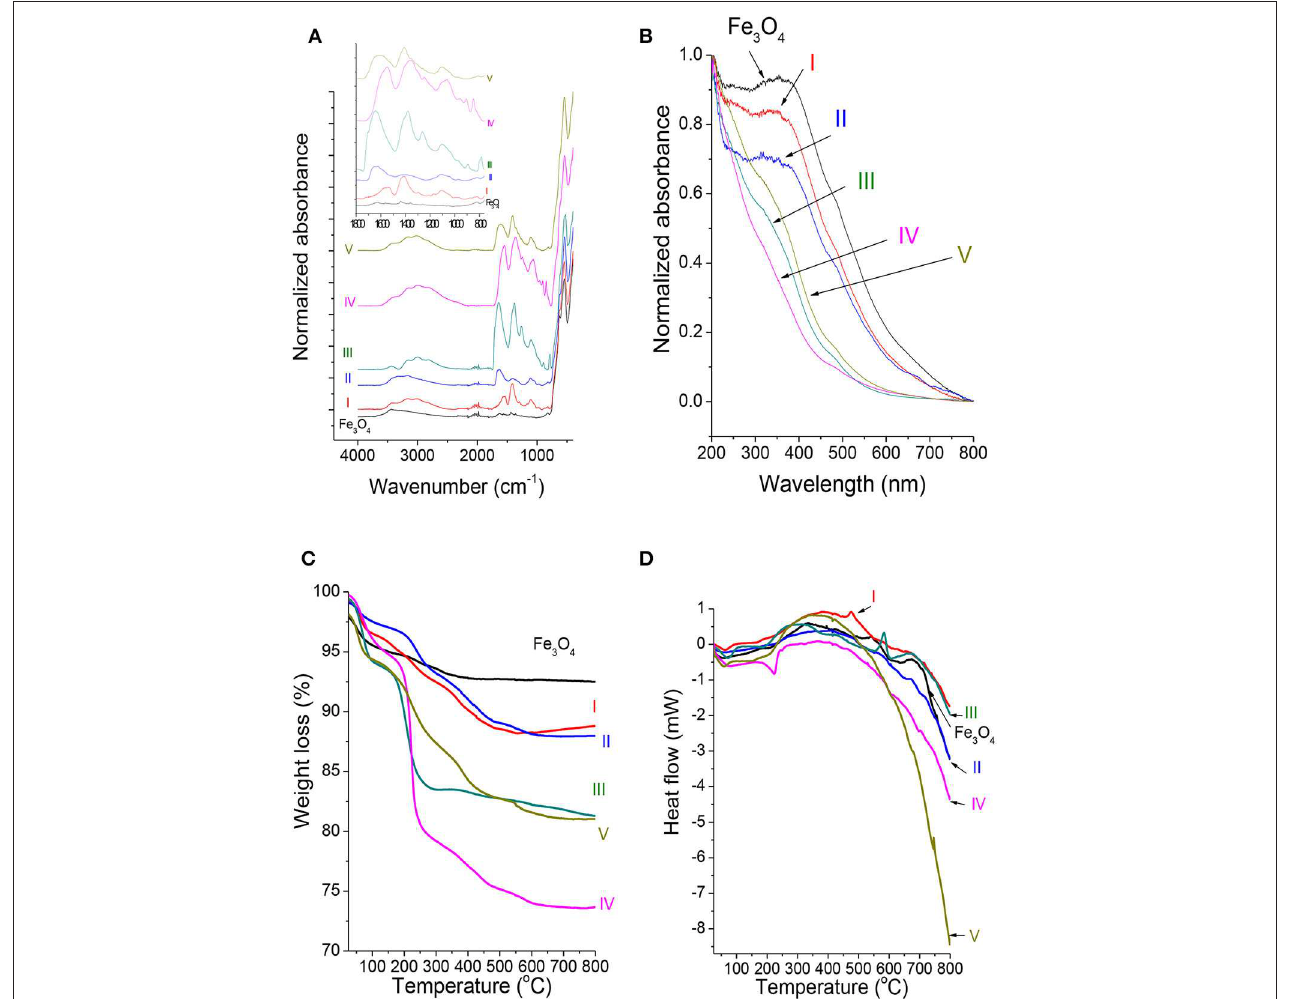
FIGURE 1 | (A) The ATR-FTIR, (B) UV-vis spectra, and (C) TGA and (D) DSC curves of the investigated Fe 3 O 4 MNPs and Fe 3 O 4 f-MNPs I–V.